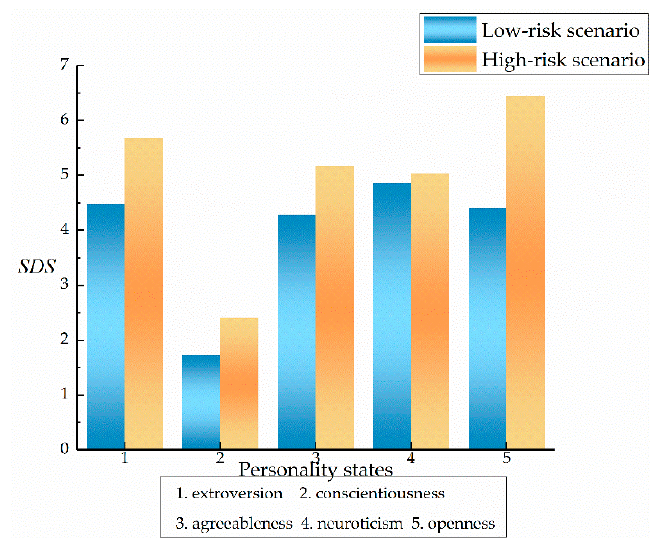
Figure 8. Comparison of v Δ for the five types of personality in risky scenarios.